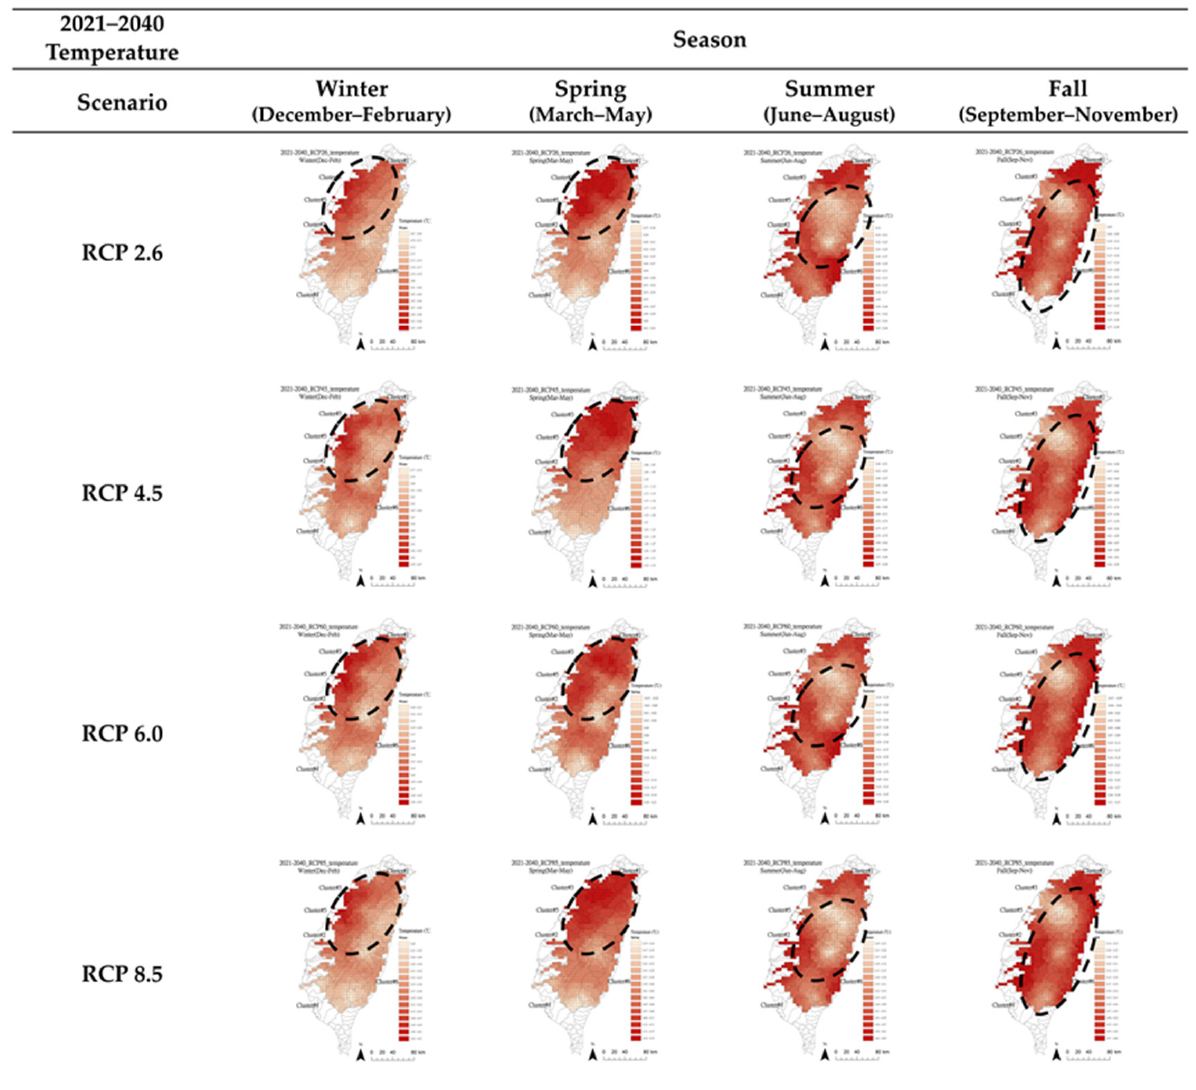
Figure A9. Spatial distribution of simulated temperature data from 2021–2040 for four seasons under different climate change scenarios.